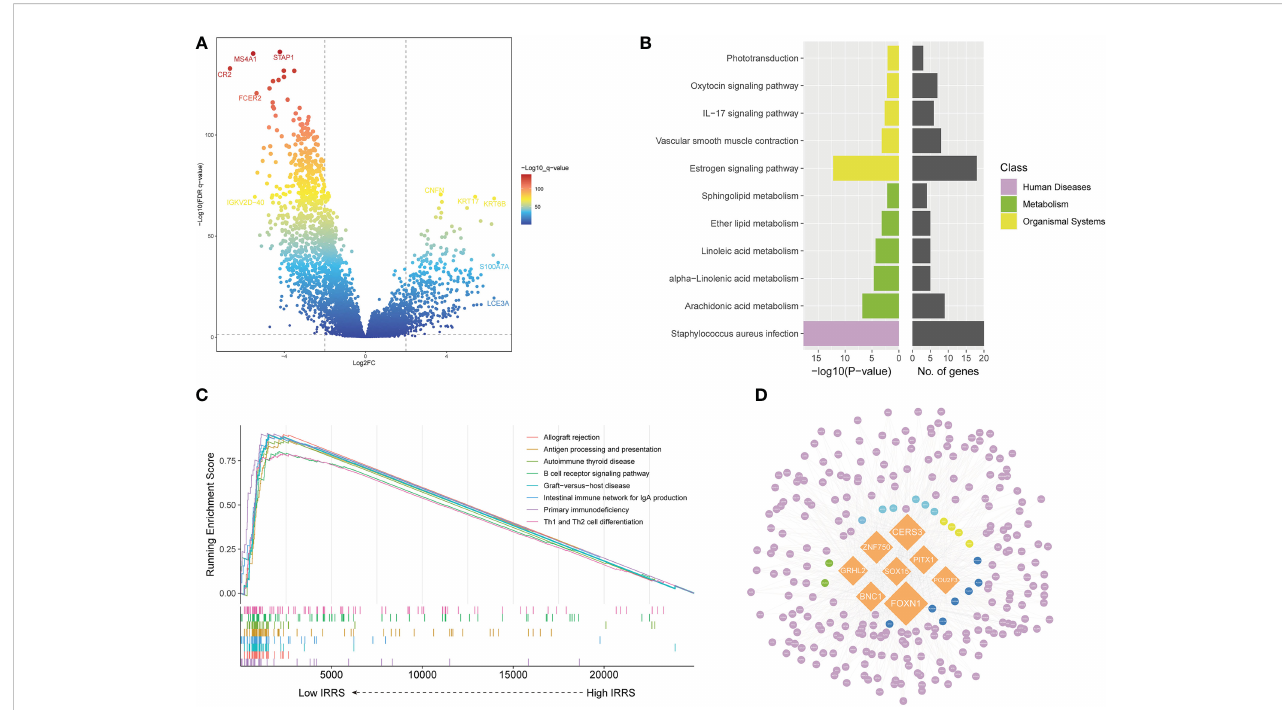
FIGURE 4 Screening of differentially expressed genes and the master regulator. (A) Volcano plot of differentially expressed genes between the low- and high-risk groups in the TCGA cohort. (B) KEGG enrichment of differentially expressed genes. (C) Gene set enrichment analysis of the high IRRS and low IRRS groups. (D) Network of the MRs and DEGs upregulated in the high IRRS group. Orange: eight MRs with the most nodes. Genes related to the KEGG enrichment pathway corresponding to each color: yellow, Staphylococcus aureus infection; green, estrogen signaling pathway; blue, both above; dark blue, arachidonic acid metabolism; purple, other